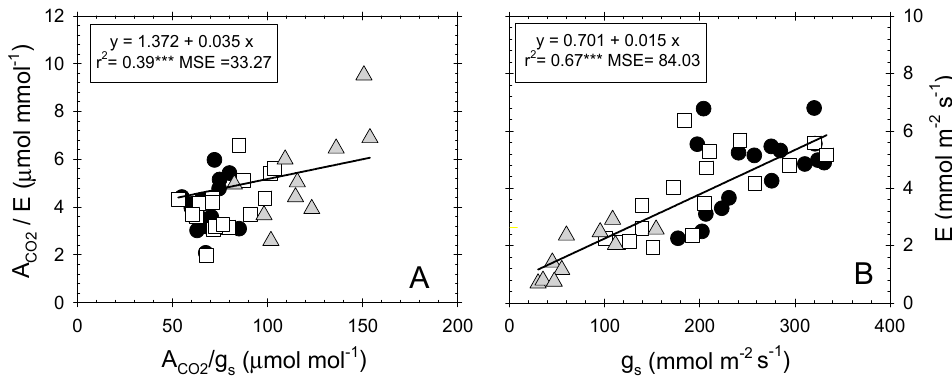
Figure 4. Relationship between (A) intrinsic water-use efficiency (A CO2 /g s , µmol mol − 1 ) and instantaneous water-use efficiency (A CO2 /E, µmol mmol − 1 ); and (B) stomatal conductance (g s , mmol m − 2 s − 1 ) and transpiration rate (E, mmol m − 2 s − 1 ) in the different irrigation treatments: T–C ( ● ), T–M ( □ ), and T–S ( ). Each point is the mean of four leaves. Coefficient of determination in (A) : T–C (r 2 = 0.002 ns), T–M (r 2 = 0.015 ns), and T–S (r 2 = 0.52***); and in (B) : T–C (r 2 = 0.25***), T–M (r 2 = 0.50***), and T–S (r 2 = 0.70***). ns: not significant, ***: p ≤ 0.001, MSE: mean squared error.